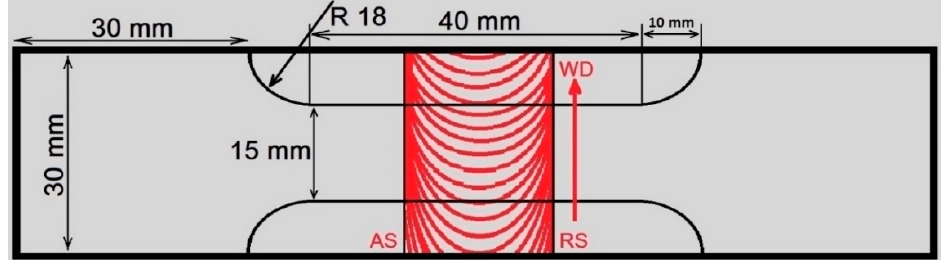
Figure 3. Schematic dimensions of the tensile test sample, made of FSW plates of AA1100.